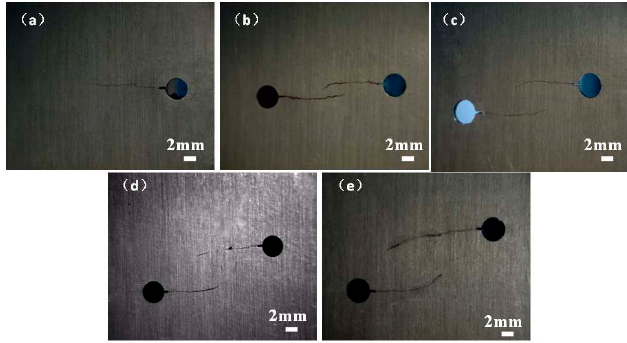
Figure 7. Crack propagation paths. ( a ) A1 with a single crack, ( b ) specimen H2.3 (initial condition: crack offset H = 2.3 mm), ( c ) specimen H4.6 (initial condition: H = 4.6 mm), ( d ) specimen H6.9 (initial